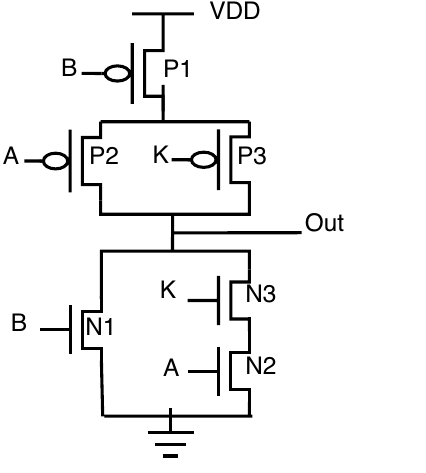
Figure 13. Secure NOR.